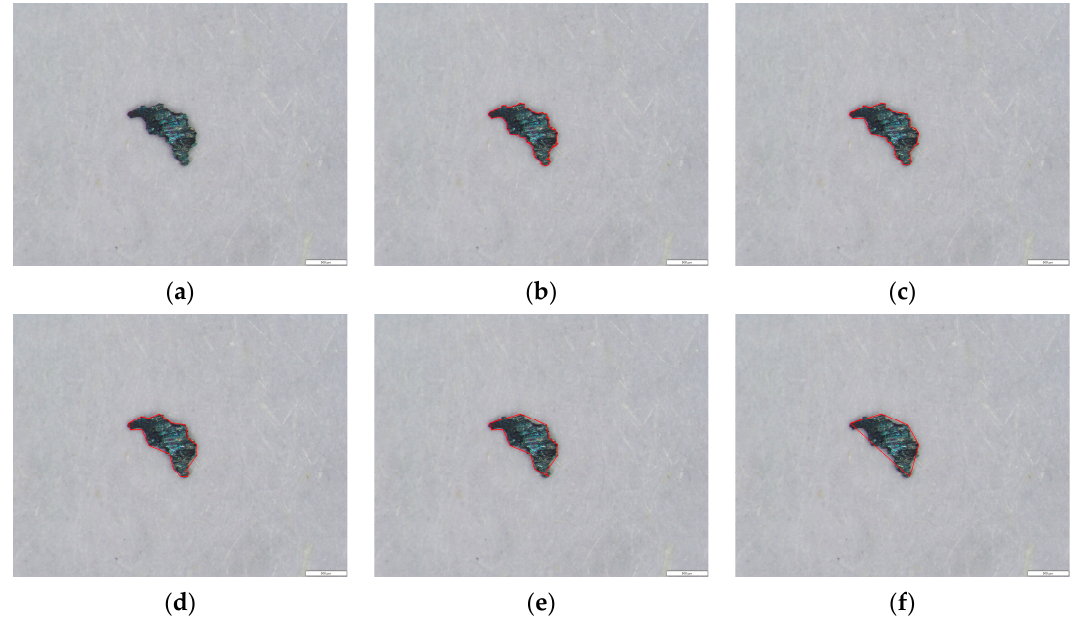
Figure 11. Contour extraction image corresponding to different epsilon values after polygon fitting: ( a ) Origin image; ( b ) epsilon = 0; ( c ) epsilon = 10; ( d ) epsilon = 20; ( e ) epsilon = 30; ( f ) epsilon = 40. The relationship between epsilon and number of corners is shown in Figure 12.